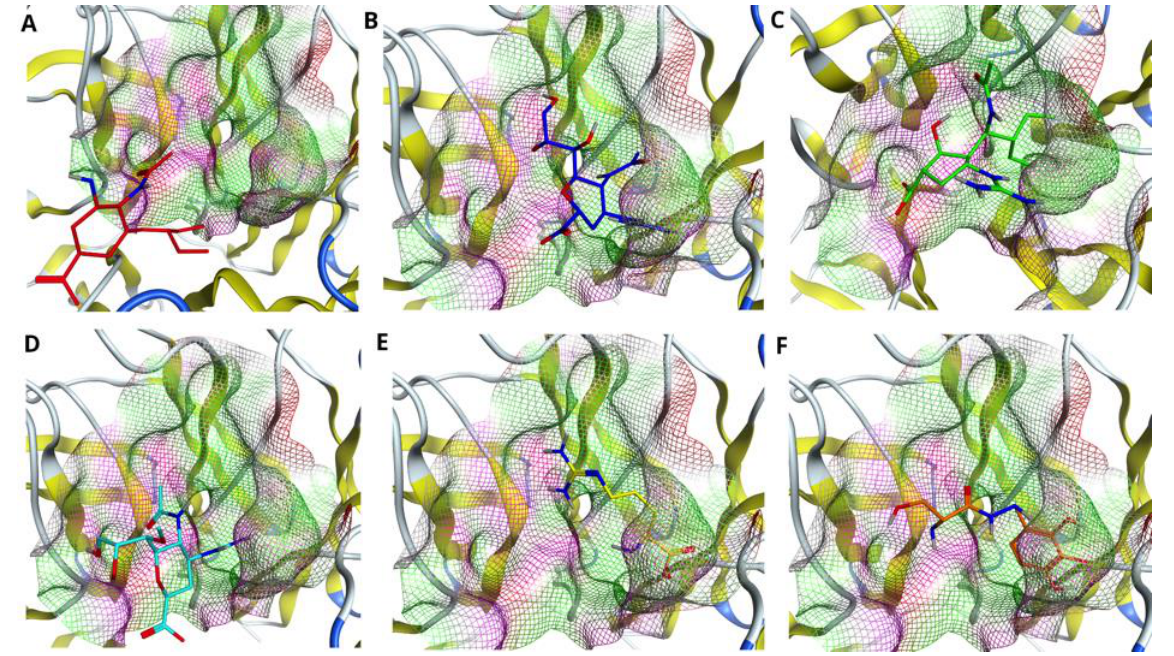
Figure 6. Comparing drug fit to triple mutated NA binding pocket. Accommodation of the drugs ( A ) Oseltamivir (red), ( B ) Zanamivir (blue), ( C ) Peramivir (green), ( D ) Laninamivir (cyan), ( E ) L-Arginine (yellow) and ( F ) Benserazide hydrochloride (orange) in the pocket of H7N9 neuraminidase with triple R294_119_372K mutation.